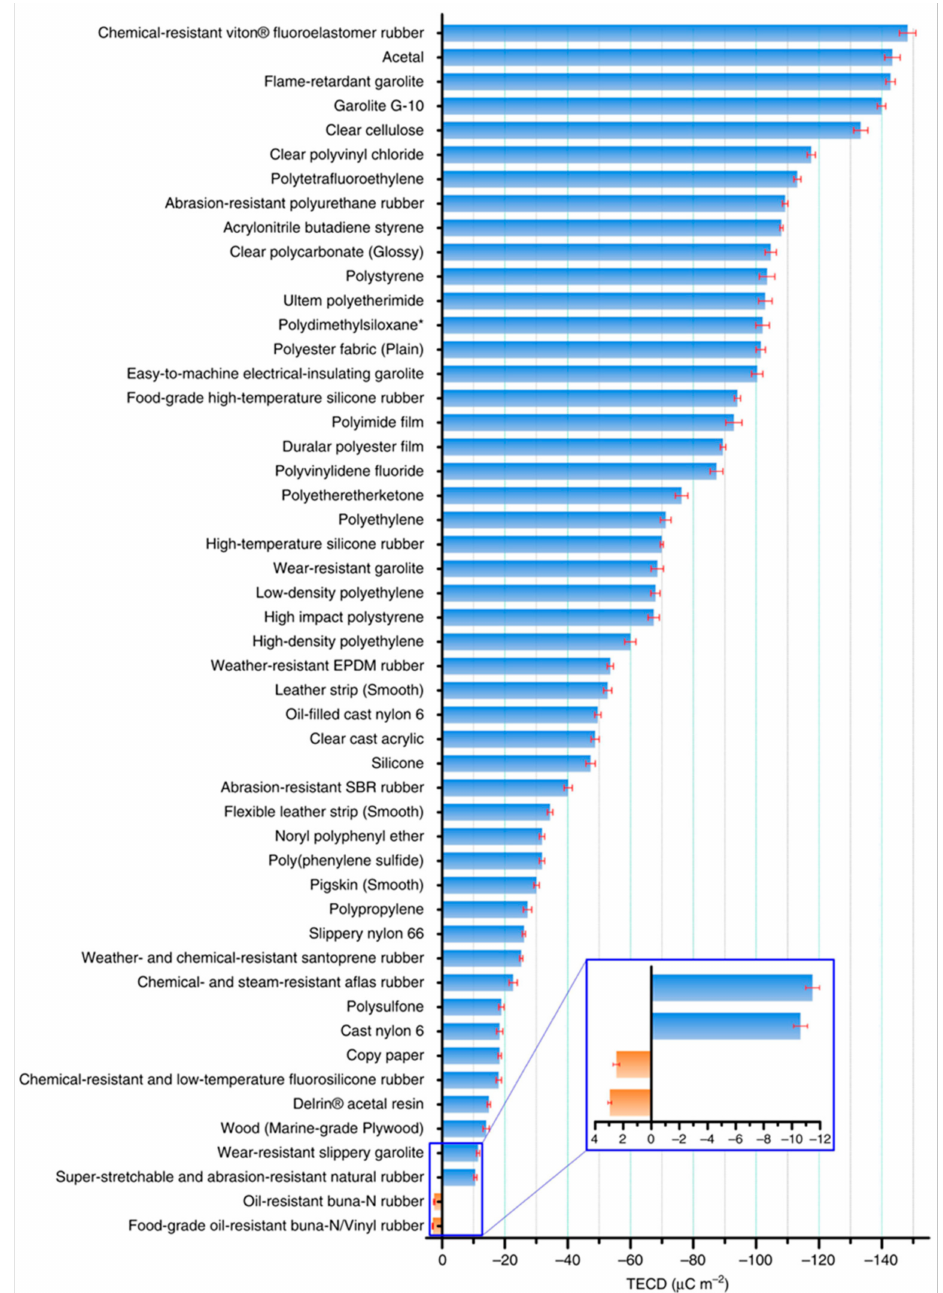
Figure 1. Example of triboelectric series calculated with respect to liquid Hg. Reprinted with permission from